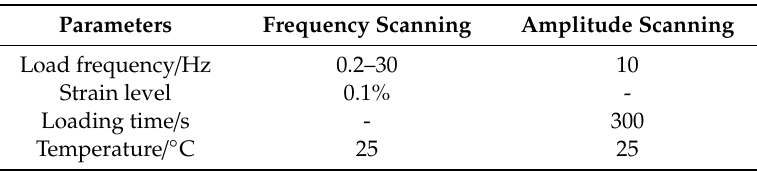
Table 13. LAS test